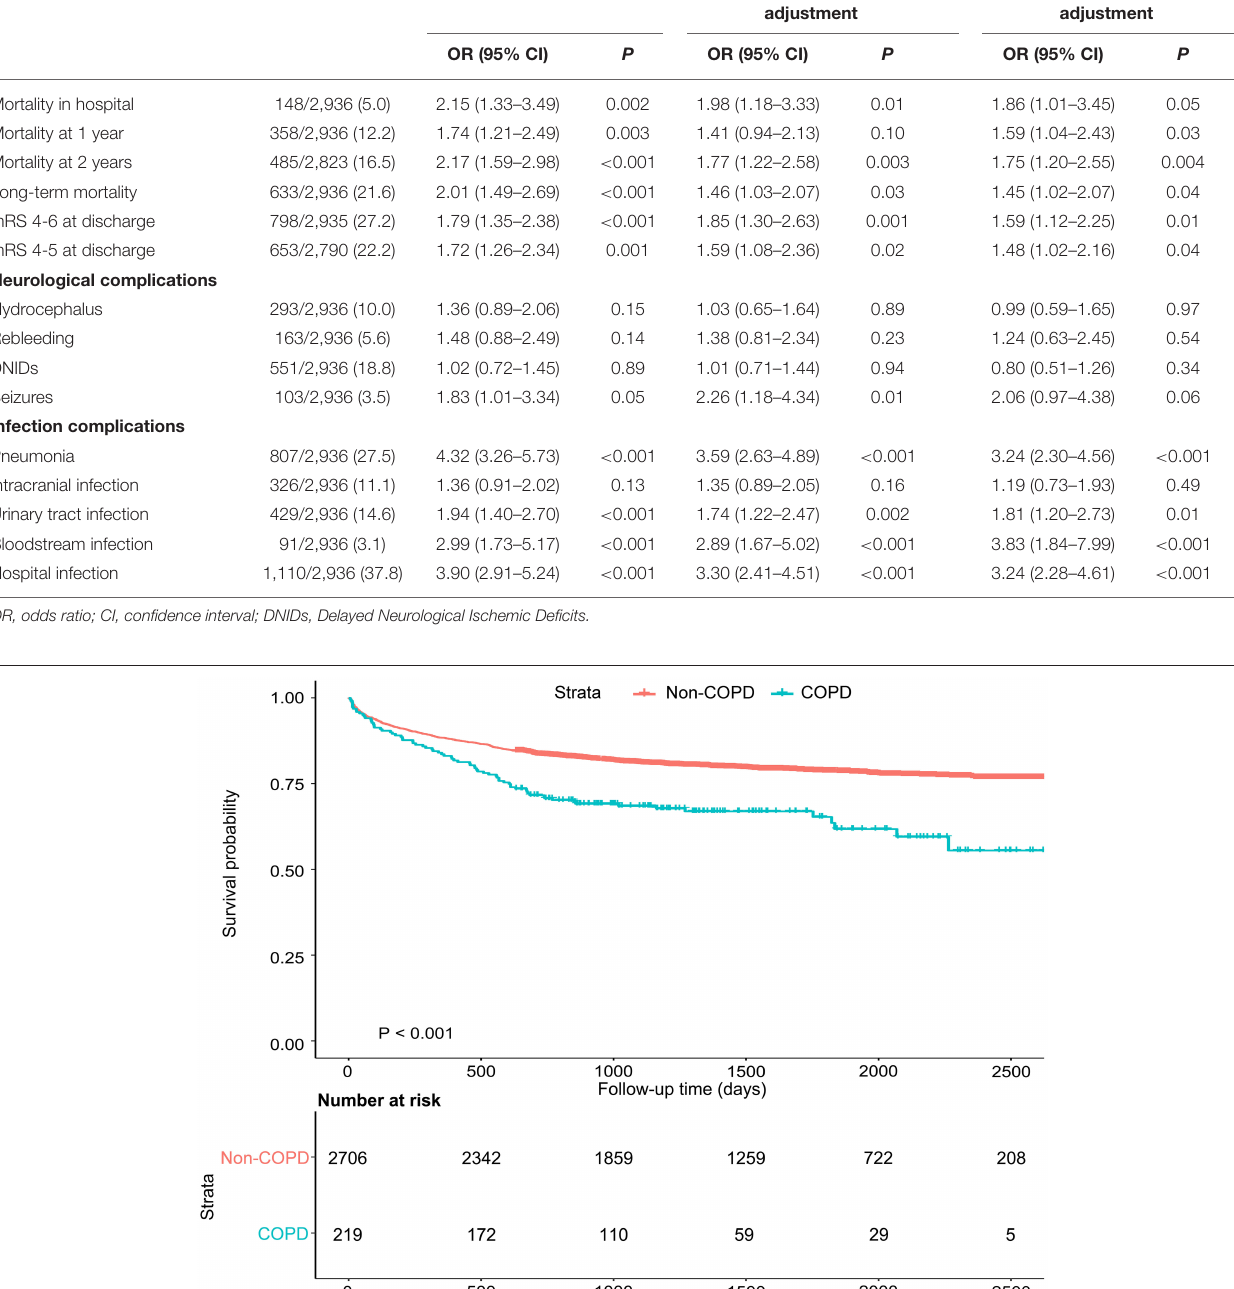
TABLE 2 | Comparison of unadjusted and risk-adjusted outcomes by COPD. Outcomes Unadjusted Multivariable regression